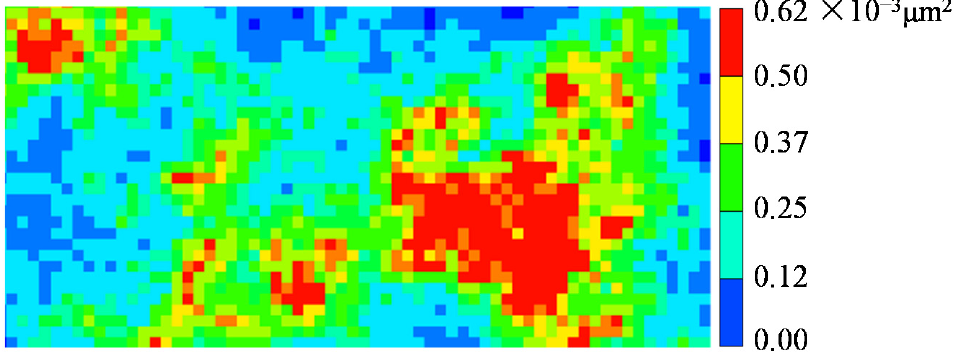
Figure 2. Permeability image and distribution of a reservoir geological model.